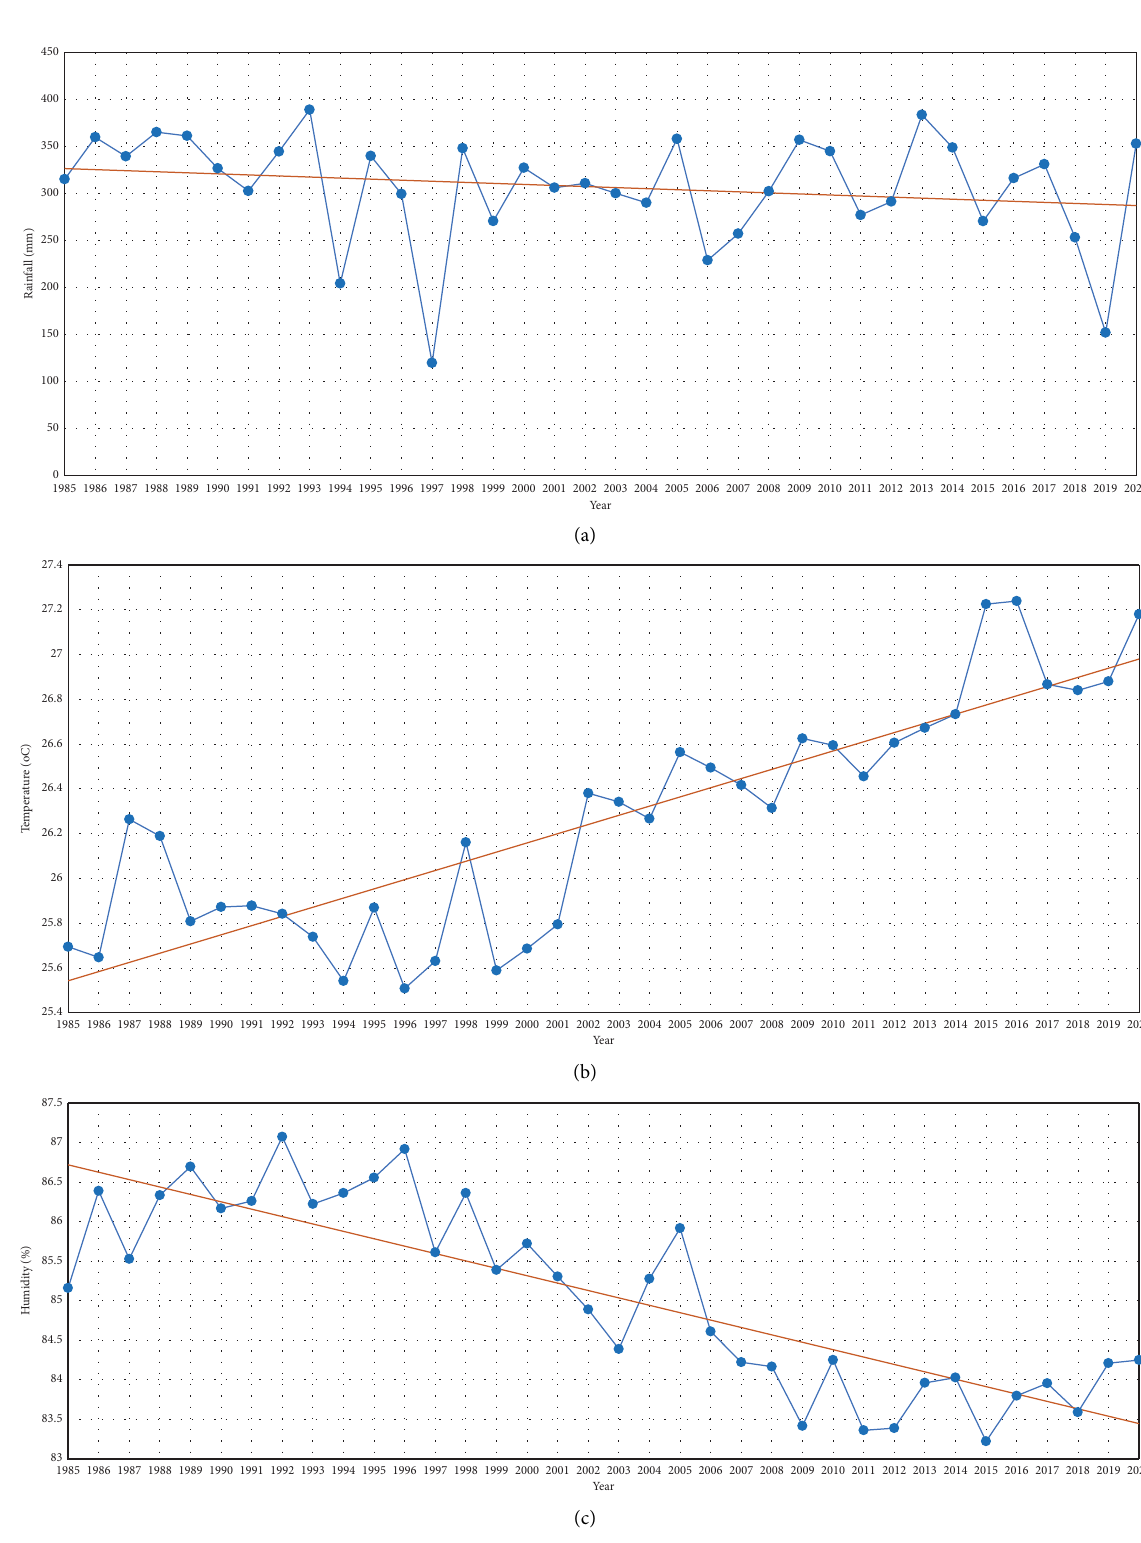
Figure 6: Graphs showing (a) average annual amount of rainfall trends, (b) average annual temperature trends, and (c) average annual humidity trends in Bengkulu Province (1985–2020) (source: BMKG Bengkulu Province,